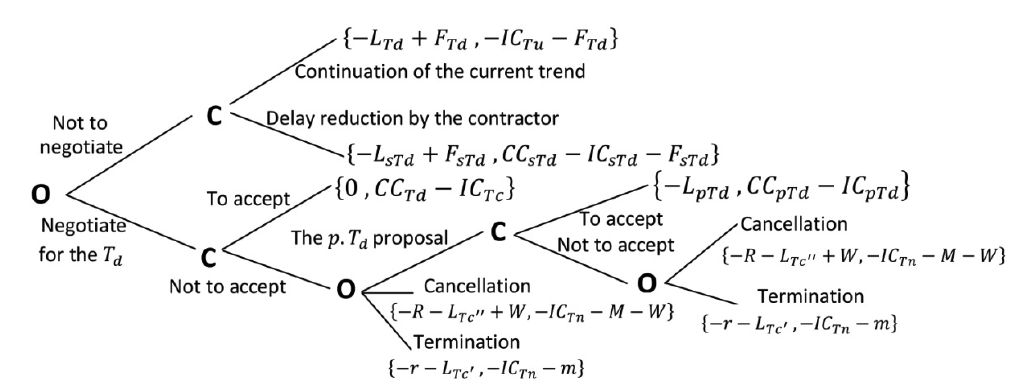
Fig. 1. Game tree for the projects facing